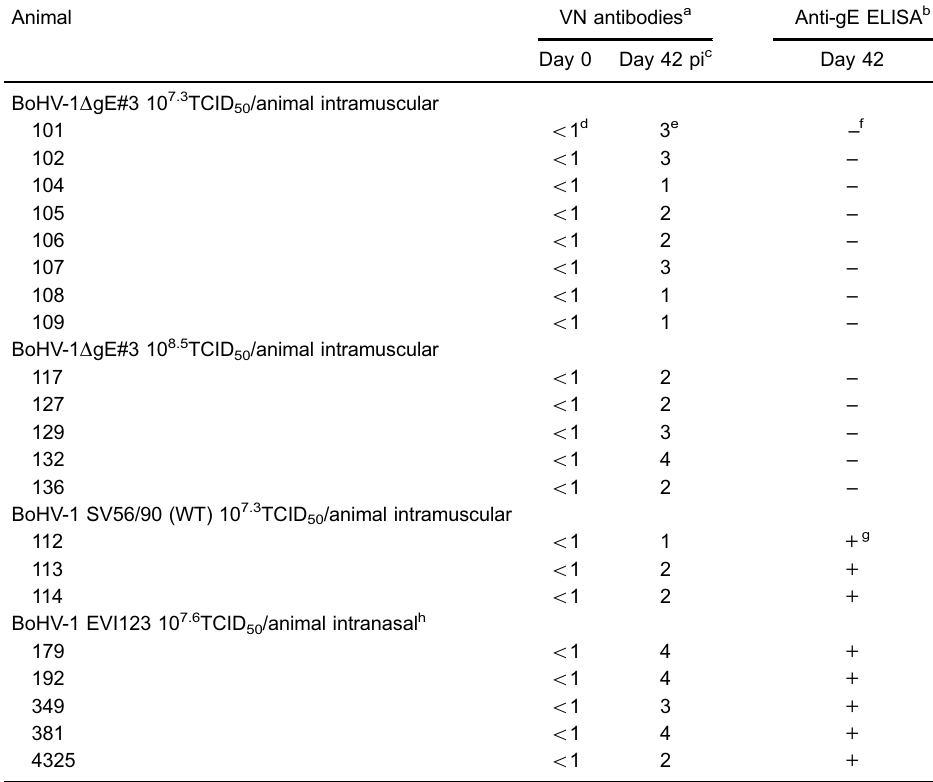
a Virus neutralizing antibodies were measured by a virus neutralization (VN) assay as described in Material and Methods. b Sera from 42 days post inoculation were subjected to a commercial anti-gE antibody ELISA test (Bovine Rhinotracheitis Virus gE Antibody Test, IDEXX, The Netherlands). c pi: post inoculation. d Sample negative in VN assay at its lower dilution (1:2). e Results from the VN assay are reported as geometrical mean titers (GMT-log f Samples negative for gE antibodies. g Samples positive for gE antibodies. h Animals from a previous study